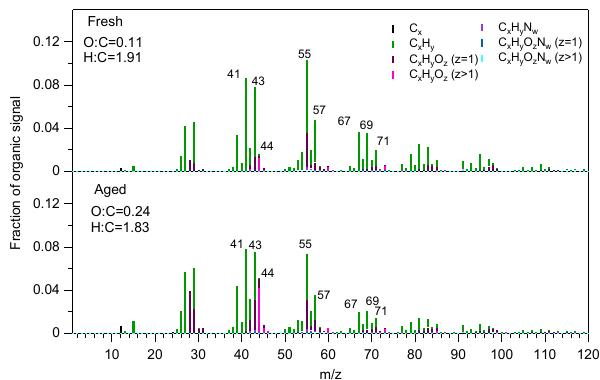
Figure 7. Mass spectra for the two resulting factors of the PMF analysis for Experiment 1.